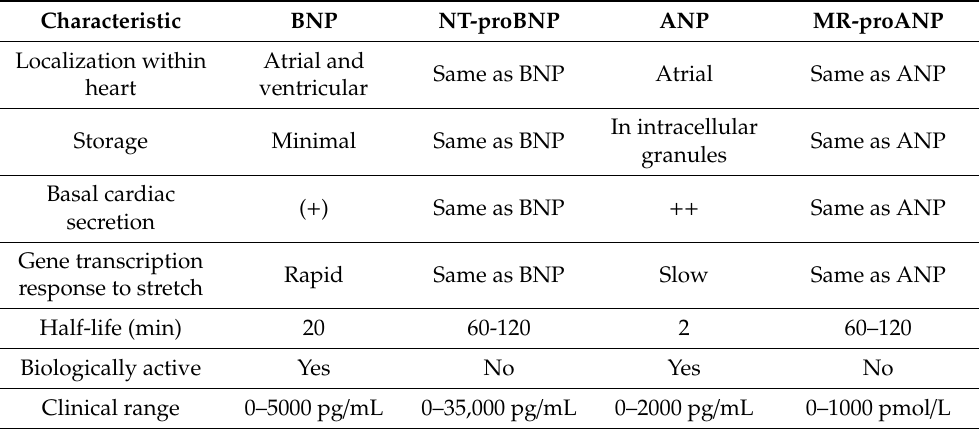
Table 1. Summary of some clinically relevant physiologic characteristics of B-type natriuretic peptide (BNP), N-terminal proBNP (NT-proBNP), atrial natriuretic peptide (ANP), and mid-regional